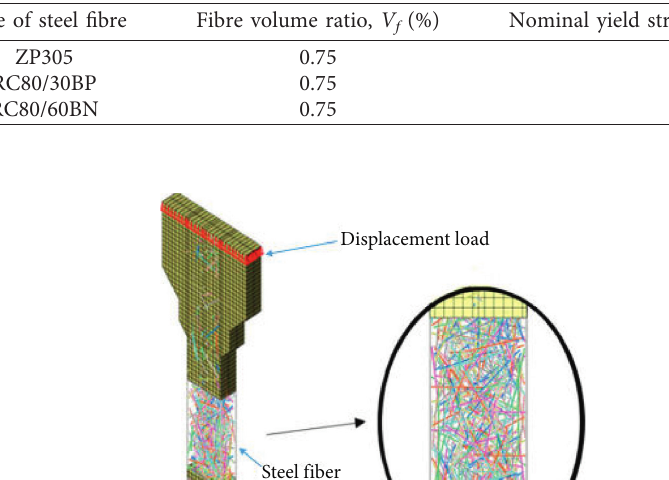
Figure 12: Direct tensile test of SFRC beams. (a) Specimen size (unit: in). (b) Test loading. Table 4: Primary parameters of steel fibre concrete tensile beams.